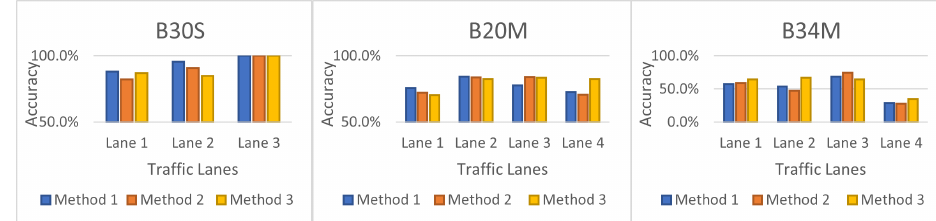
Figure 9. Queue length performance evaluation results (with original pretrained 80-classes